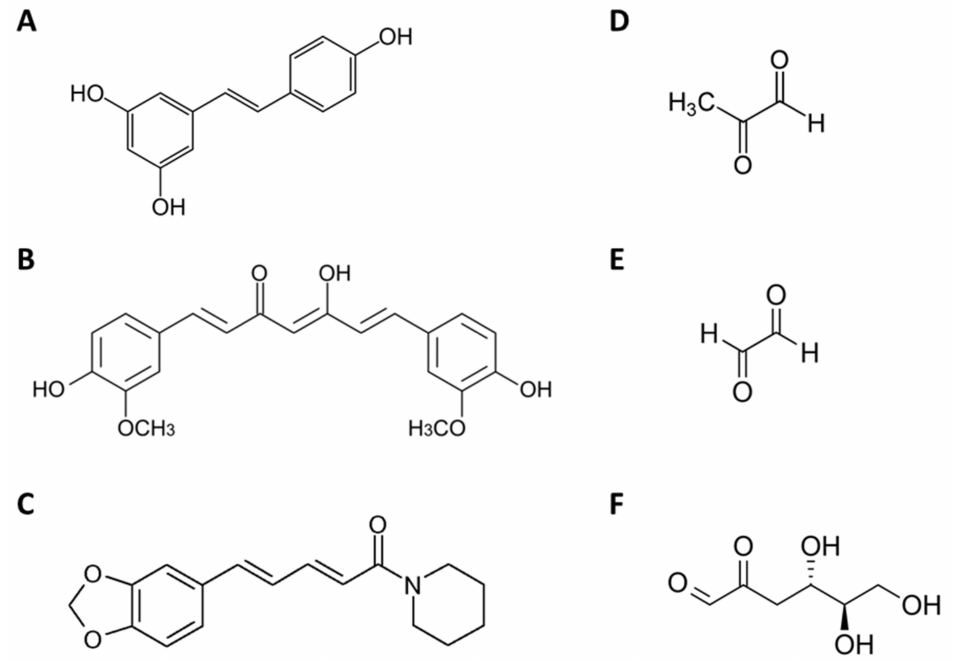
Figure 1. Chemical structure of resveratrol ( A ), curcumin ( B ), piperine ( C ), methylglyoxal ( D ), glyoxal ( E ) and 3-deoxyglucosone ( F